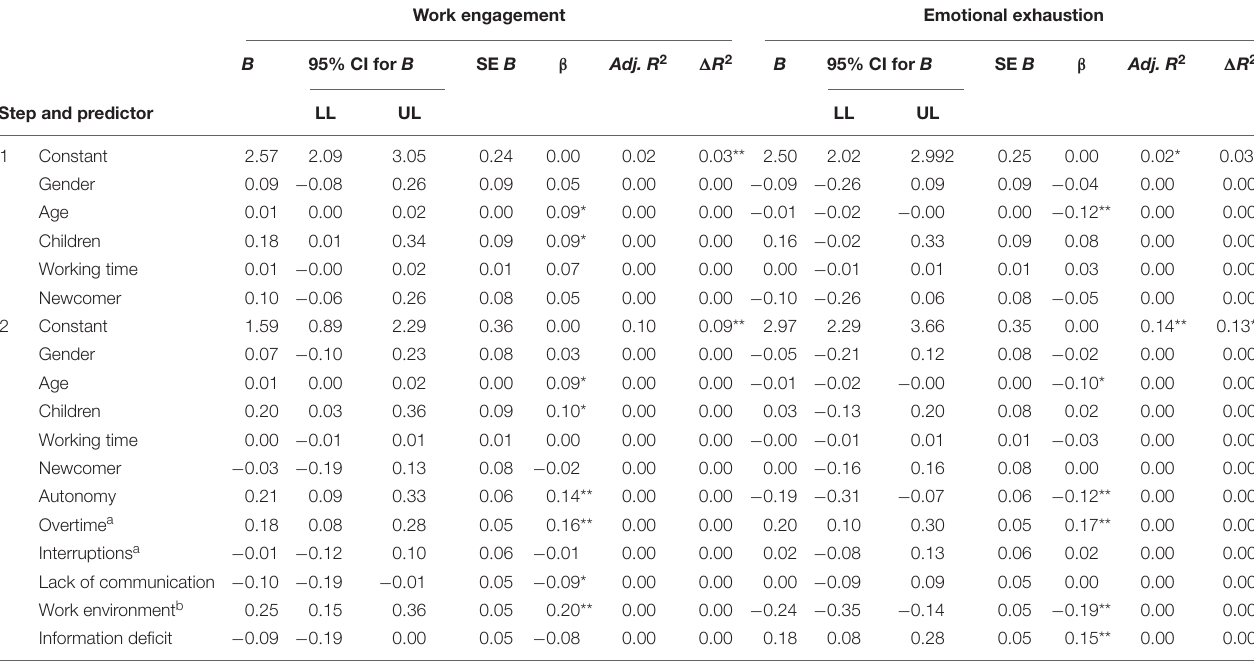
TABLE 4 | Hierarchical regression analyses on work engagement and emotional